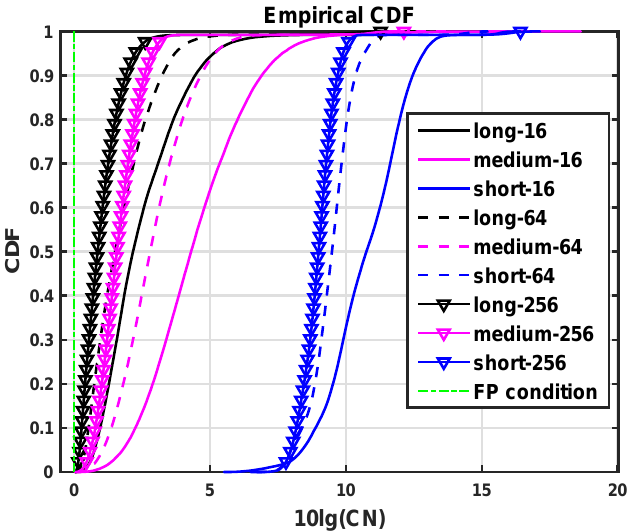
Figure 12. Condition numbers in a practical measurement scenario with different antenna configurations.